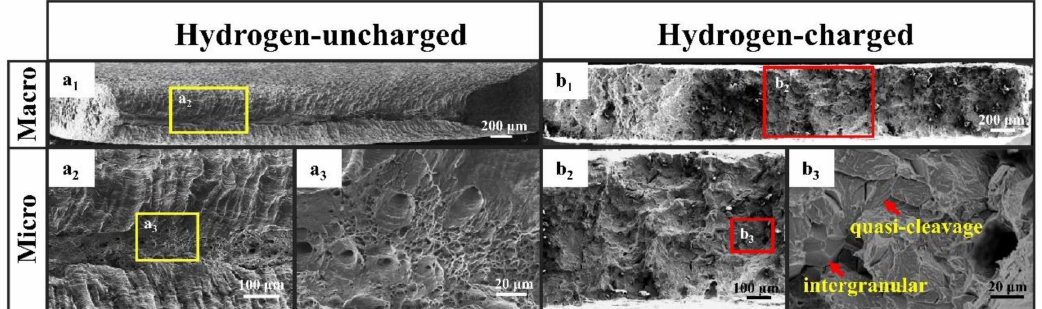
Figure 4. Fractographs of hydrogen-uncharged ( a 1 – a 3 ) and hydrogen-charged specimens ( b 1 – b 3 ): ( a 1 ) the overall morphology; ( a 2 ) the yellow box area in a 1 , low magnification; ( a 3 ) the local magnified image of the yellow box in ( a 2 ); ( b 1 ) the overall morphology; ( b 2 ) the red box area in ( b 1 ), low magnification; ( b 3 ) the local magnified image of the red box in ( b 2 ), red arrows represent intergranular crack (IC) and quasi-cleavage area.